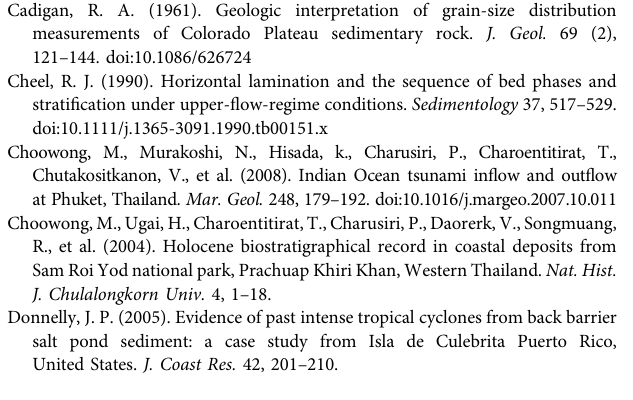
Supplementary Table 1 | OSL Decay curve and Growth curve of each sample. Supplementary Table 2 | Recycling ratio of each sample. Supplementary Table 3 | Sediment composition, sphericity and